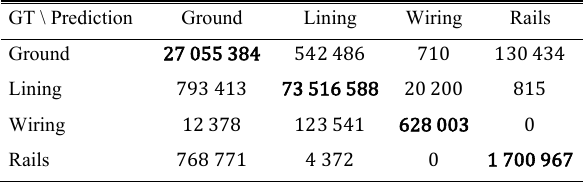
1 700 967 Table 2. Confusion matrix for the results obtained from the KPConv model with transfer learning In order to provide more insight into the performance of the test, Table 3 includes the main classification metrics, including the precision and recall of the predictions as well as the F1-score.